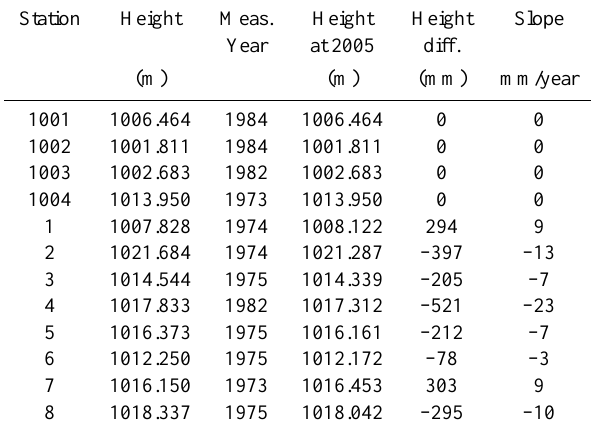
Table 1. Comparison of the heights from precise leveling in differ- ent time periods, 1973–1984 and 2005 (Anonymous,